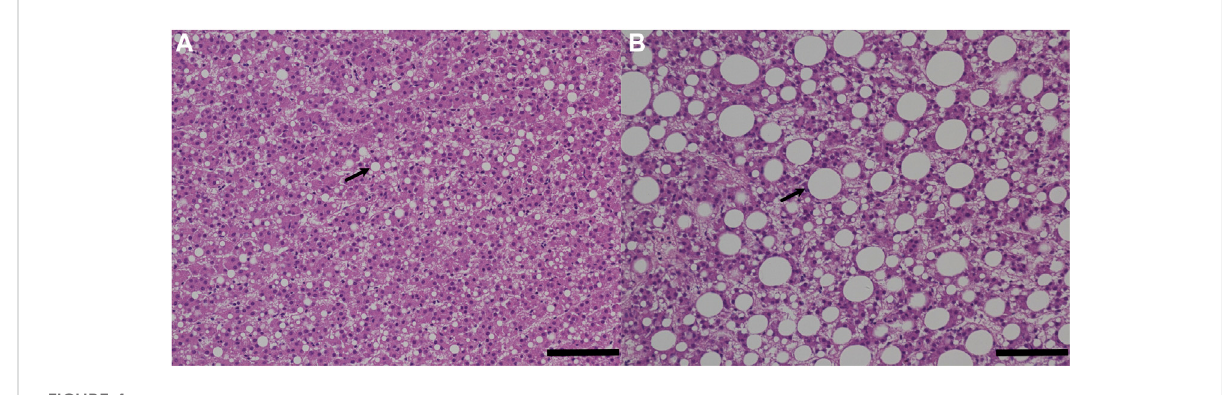
FIGURE 4 Histological analysis of fi sh livertissues. The barscale represents 100 µm.The imageon theleft (A) iscontrol fi sh,and theimageon theright (B) is experimental fi sh with signs of hepatic steatosis. Arrows point out lipid